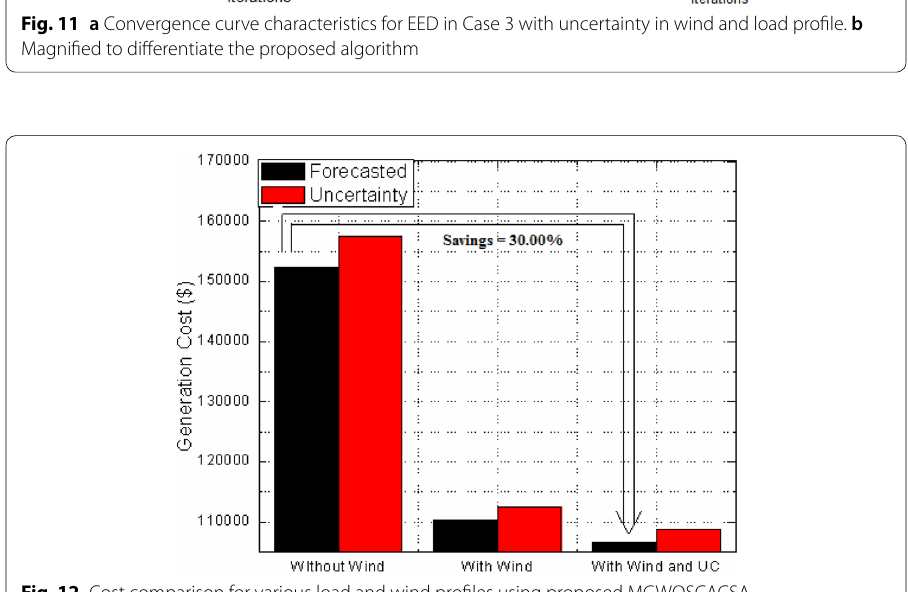
Fig. 12 Cost comparison for various load and wind profiles using proposed